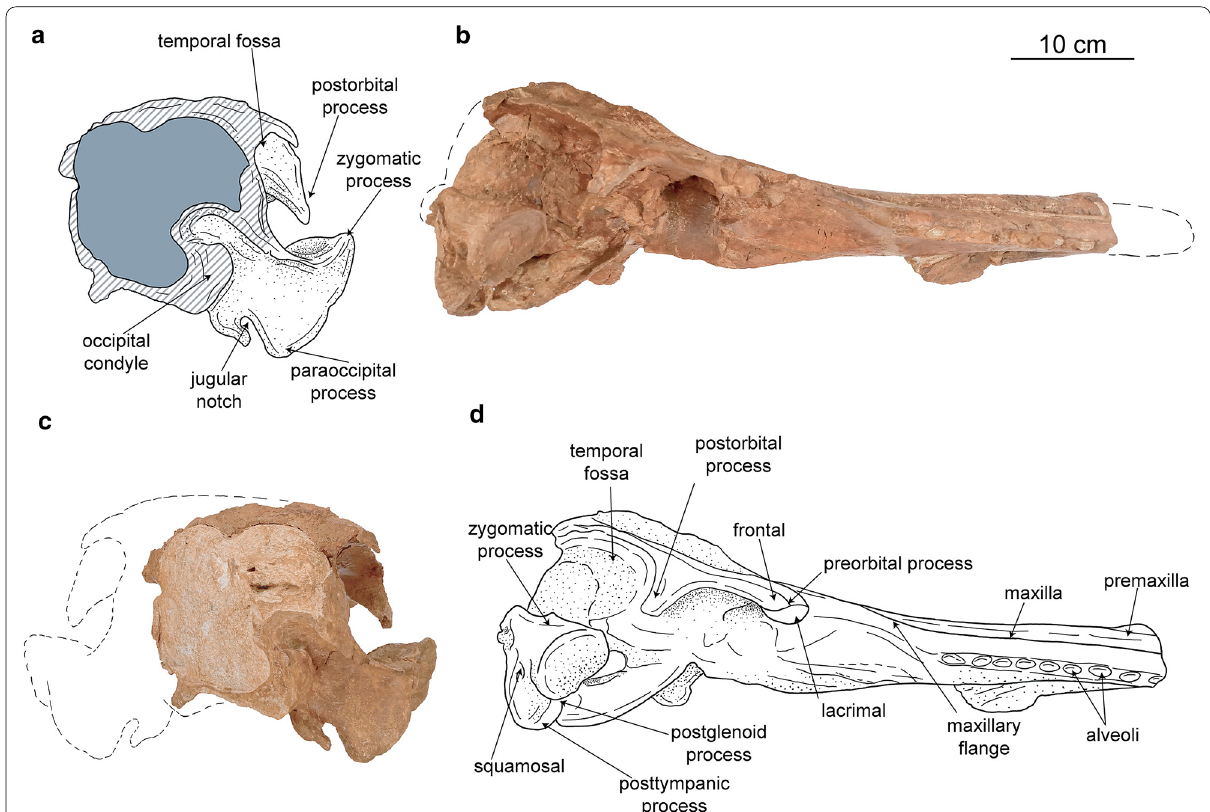
Fig. 4 Caujarao delphinidan, MTT‑V‑558 referred skull in posterior ( a , c ) and lateral ( b , d ) views. Dashed fill represents eroded bone, and gray areas indicate